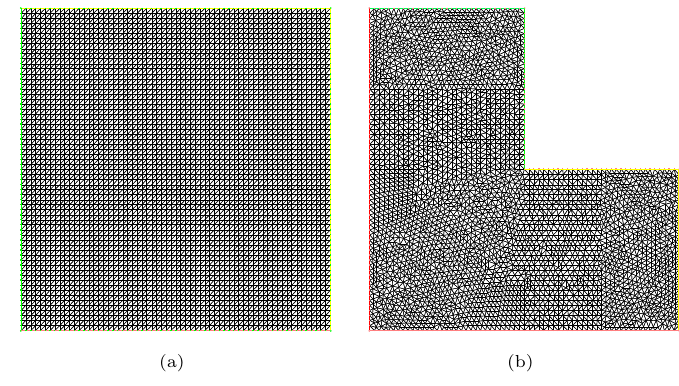
Figure 1. Domain. (a) the base triangles of Example 1; (b) the base triangles of Example 2.